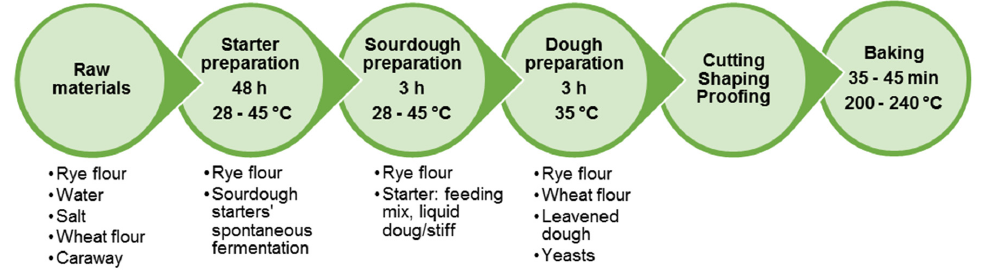
Figure 4. Flowchart of traditional rye bread production.